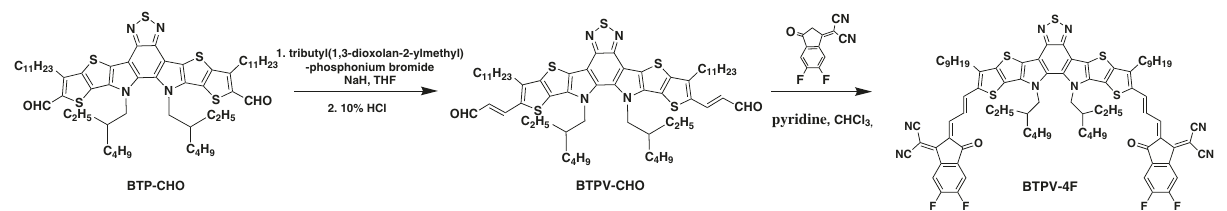
Fig. 2 BTPV-4F synthesis. The synthetic route of